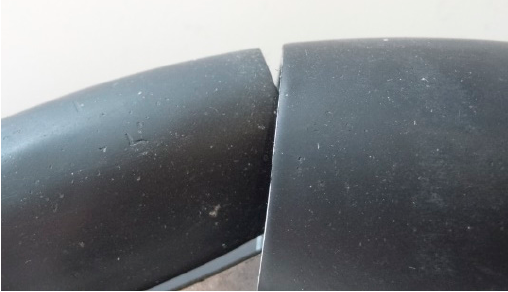
Figure 4. Detail of the gap between the passive rollers.